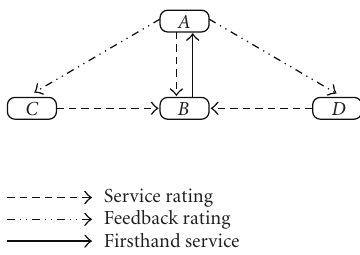
Figure 1: Decoupling service and feedback reputation: after inter- acting with B , peer A modifies B ’s service reputation and also mod- ifies the feedback reputations of B ’s previous raters, C and D